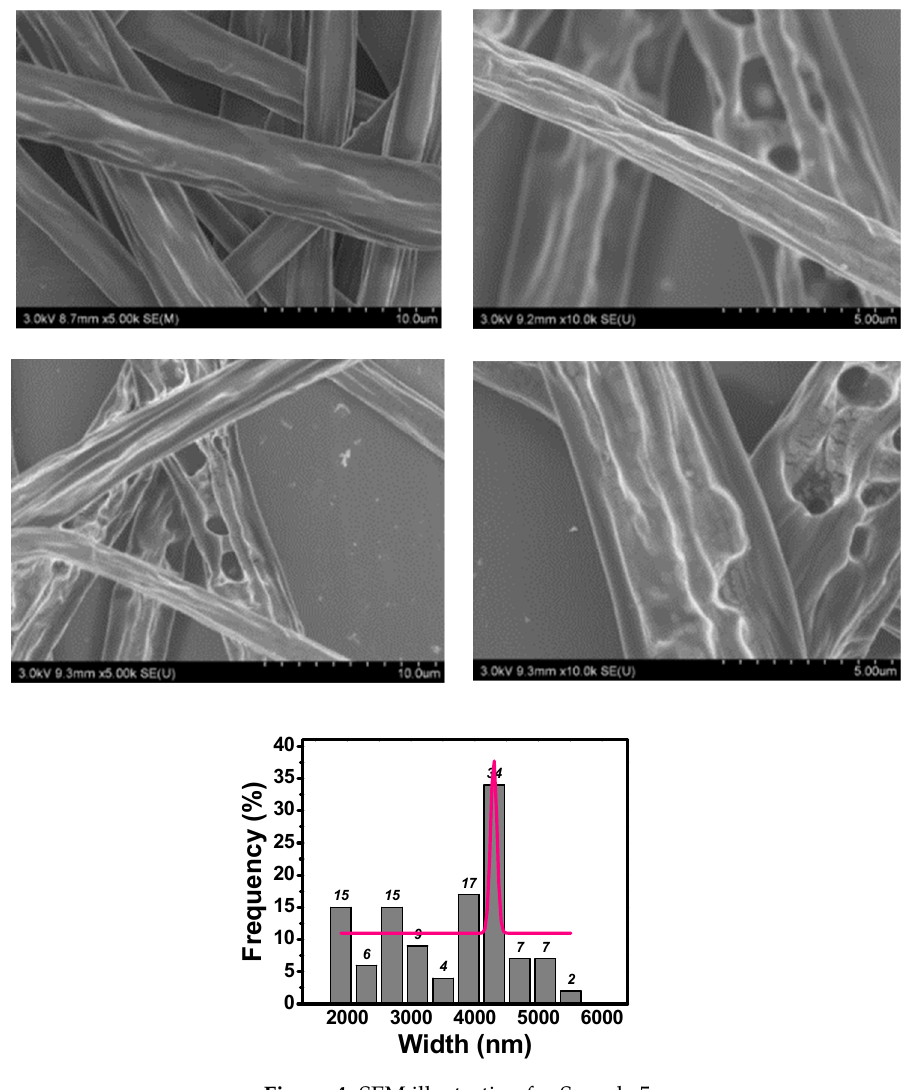
Figure 4. SEM illustration for Sample 5.